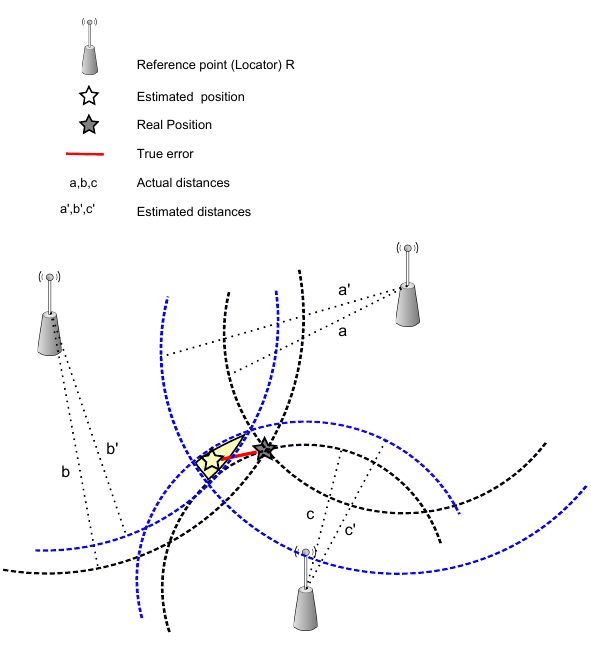
Figure 5. Time of arrival (ToA)-based